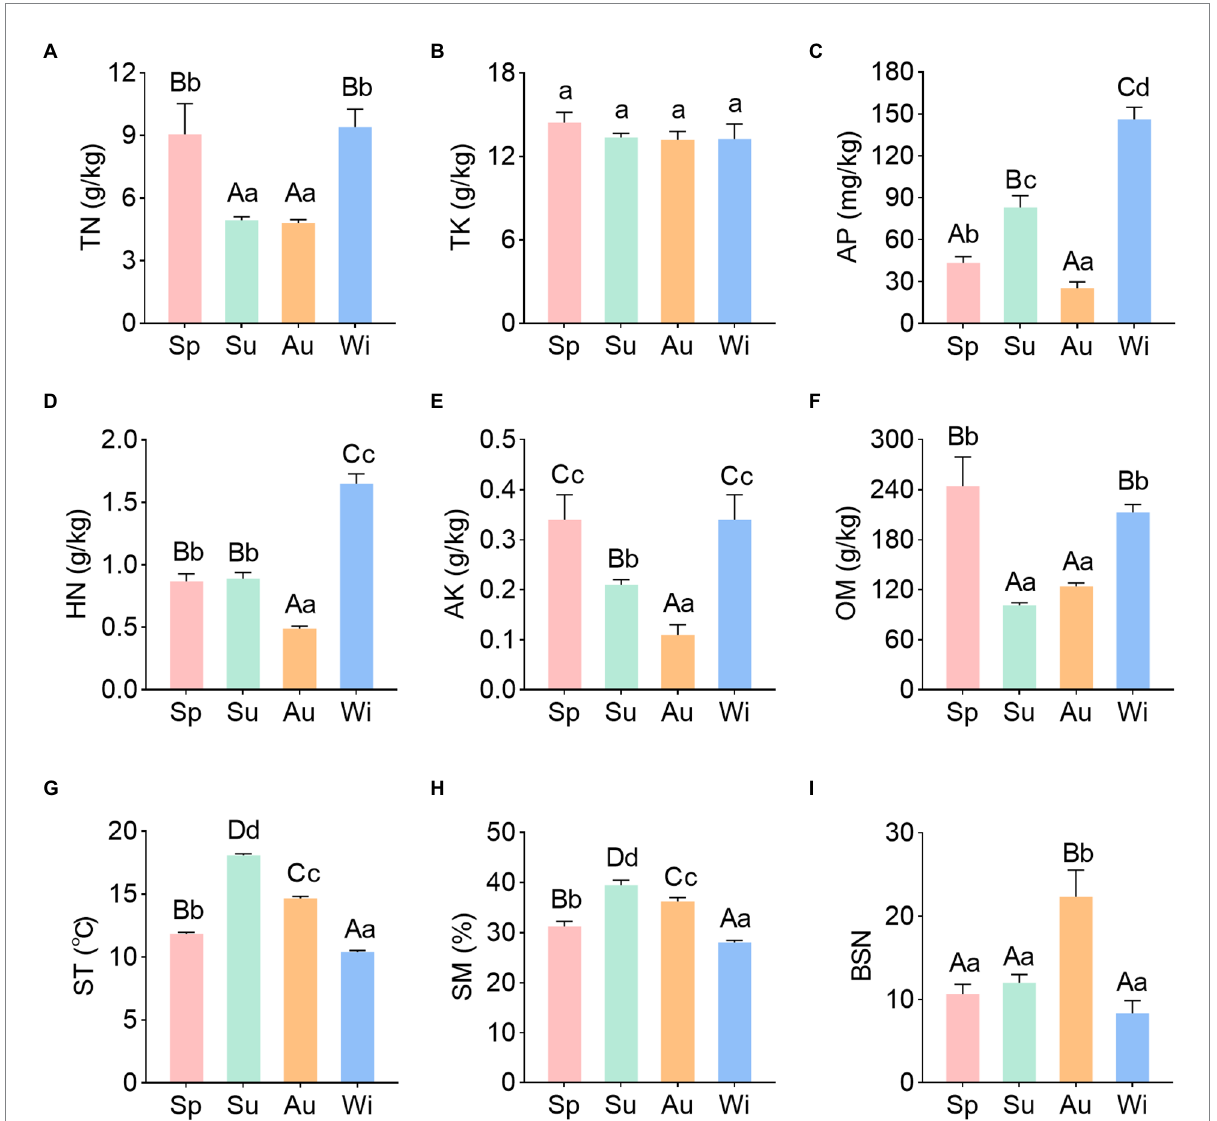
FIGURE 1 Soil physicochemical properties (A–H) and bamboo shoot number (I) of C . pingbianense in the four seasons. Different uppercase and lowercase letters in each subgraph indicated significant differences at p < 0.01 and p < 0.05 levels respectively, and error bars represented standard deviation (SD). TN, total nitrogen; TK, total potassium; AP, available phosphorus; HN, hydrolyzable nitrogen; AK, available potassium; OM, organic matter; ST, soil temperature; SM, soil moisture; BSN, bamboo shoot number; Sp, spring; Su, summer; Au, autumn; Wi,